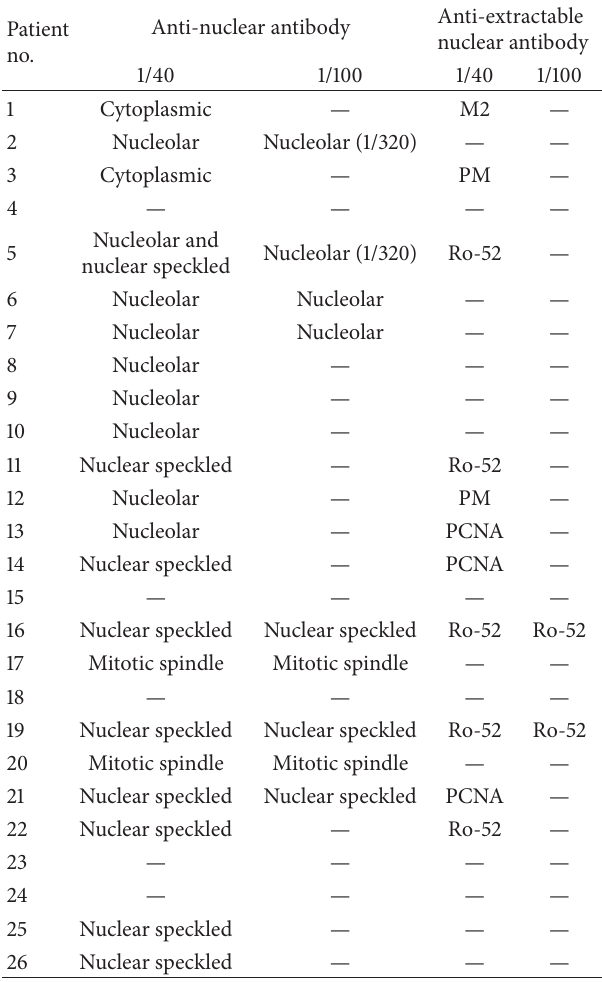
Table 1: Distribution of ANA patterns and ENA positivity in patients with